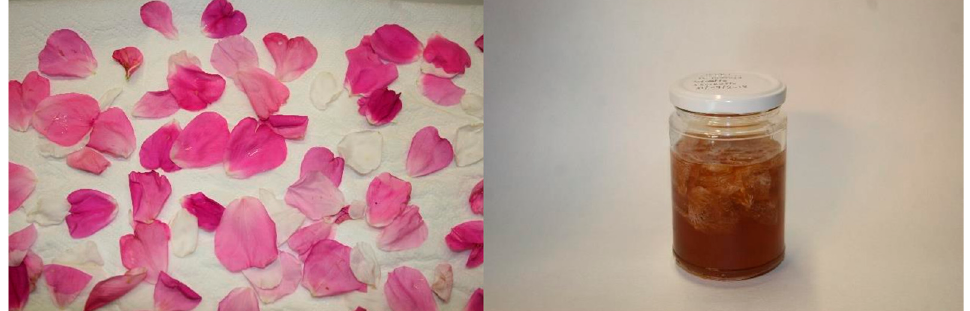
Figure 2. Fresh petals of Rosa rugosa flowers ( left ); maceration of cv. Rubra petals ( right ) .